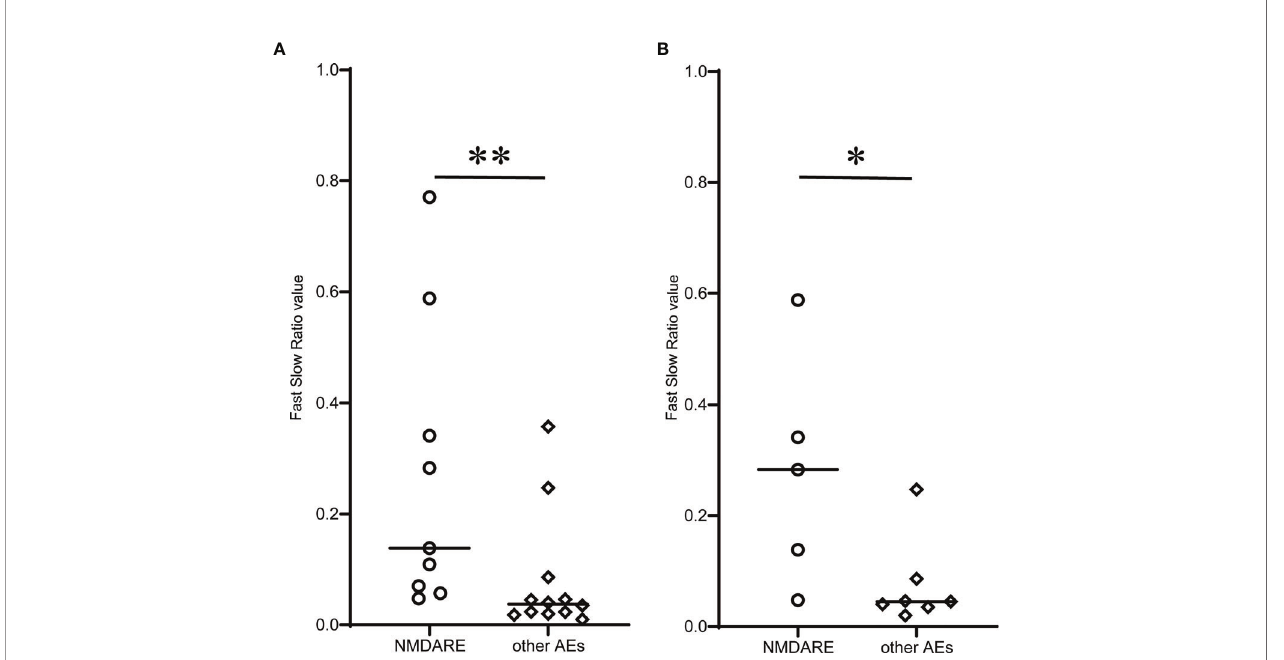
FIGURE 3 | Comparison of novel qEEG parameter Fast Slow Ratio (FSR) between NMDARE and other AEs groups. (A) shows FSR of all patients, and (B) shows FSR of sedative-free population in each group. Circles and rhombuses indicate FSR of individual cases of NMDARE and other AEs groups, respectively, and horizontal bars indicate the median of each group. Signi fi cantly higher FSR in the NMDARE group than other AEs group was observed both when all patients were included and when only the sedative-free population was included. The statistical signi fi cance was tested using Mann – Whitney U test. *p < 0.05, **p <